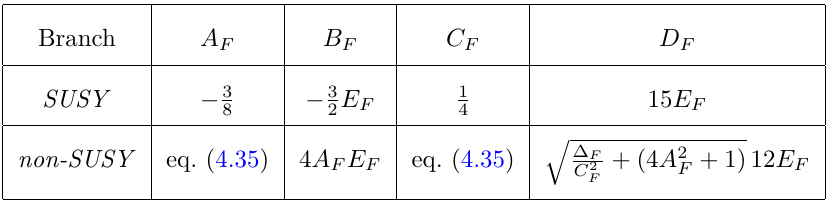
Table 2 . Branches of solutions in terms of the quotients A F = A/F , etc. of the parameters of the Ansatz (4.19). In the SUSY branch E F is not constrained by the equations of motion, while in the non-SUSY extrema it is given by (4.34). Moreover ∆ F is given by (4.31), being always zero in the SUSY